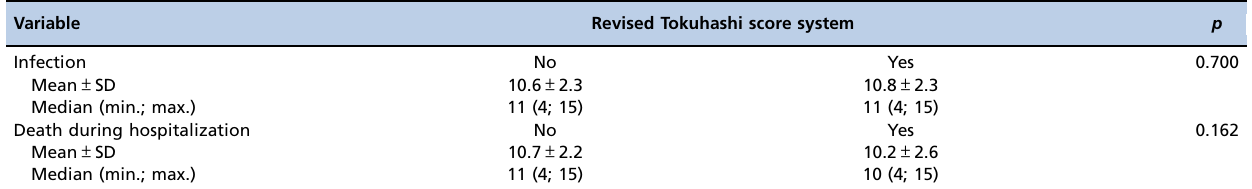
t-Student test. SD: standard